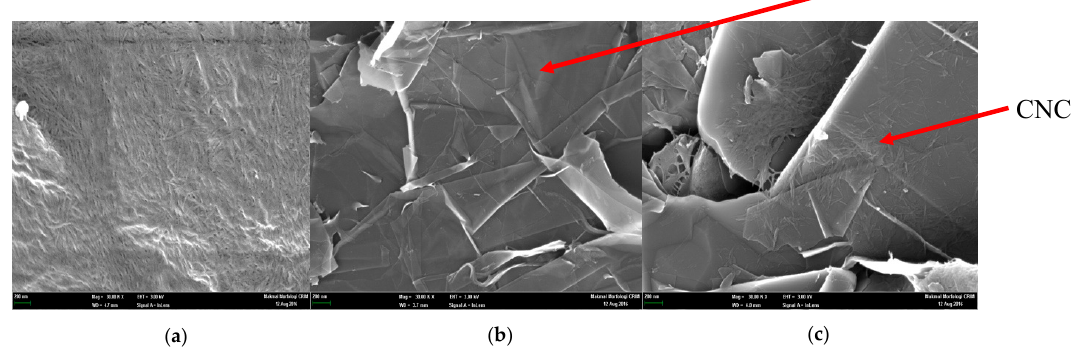
Figure 2. Field-emission scanning electron microscopy (FESEM) image of the ( a ) cellulose nanocrystal (CNC), ( b ) reduced graphene oxide (rGO), and ( c ) nanocomposite CNC – rGO at 30,000× magnification.